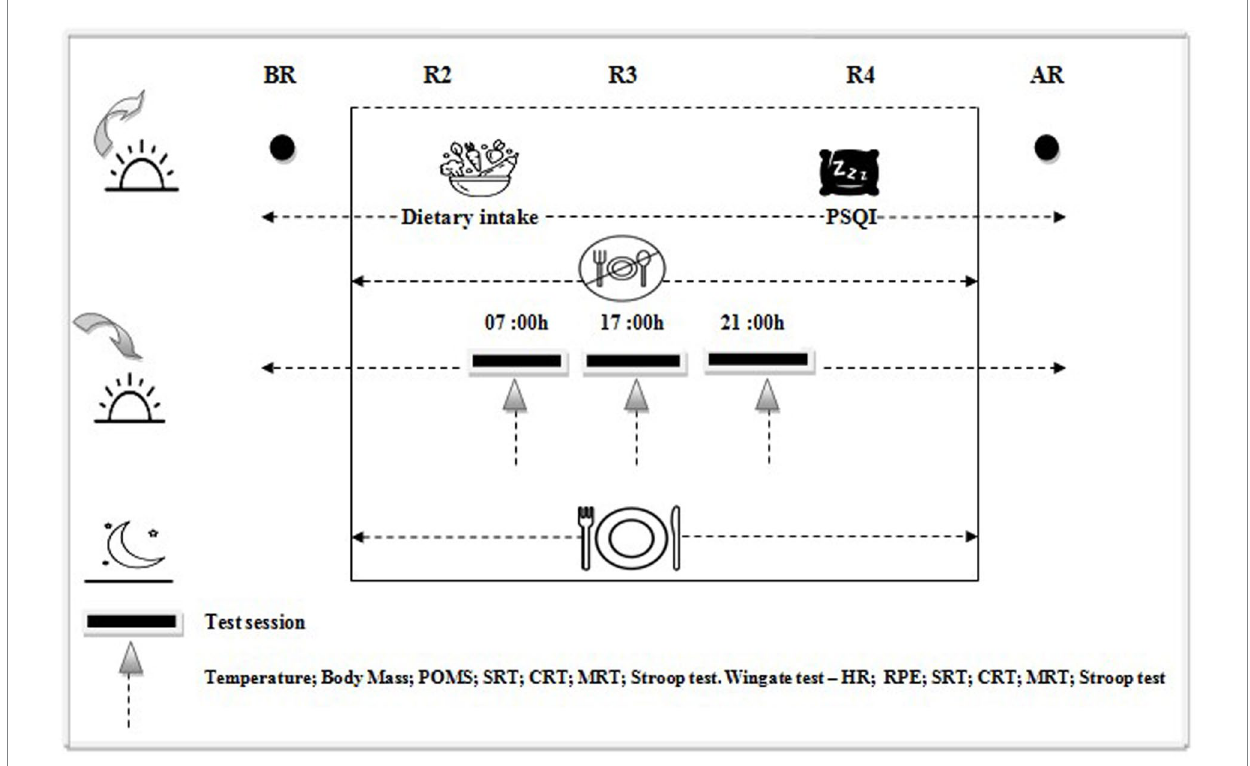
FIGURE 1 Study design. BR; 1 week before Ramadan, R2; the 2nd week of Ramadan, R3; the 3rd week of Ramadan, R4; the 4th week of Ramadan, AR; 2 weeks after Ramadan, PSQI; Pittsburgh Sleep Quality Index, SRT; Simple reaction time, CRT; Choice reaction time, MRT; Mental rotation test, POMS; Profile of Mood States, all times given are expressed in local time (GMT + 1